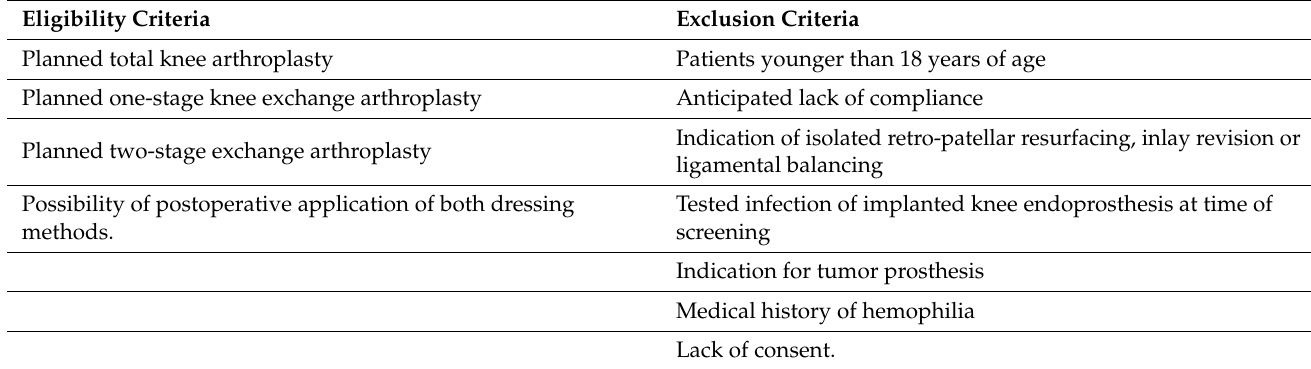
Table 1. Eligibility and exclusion